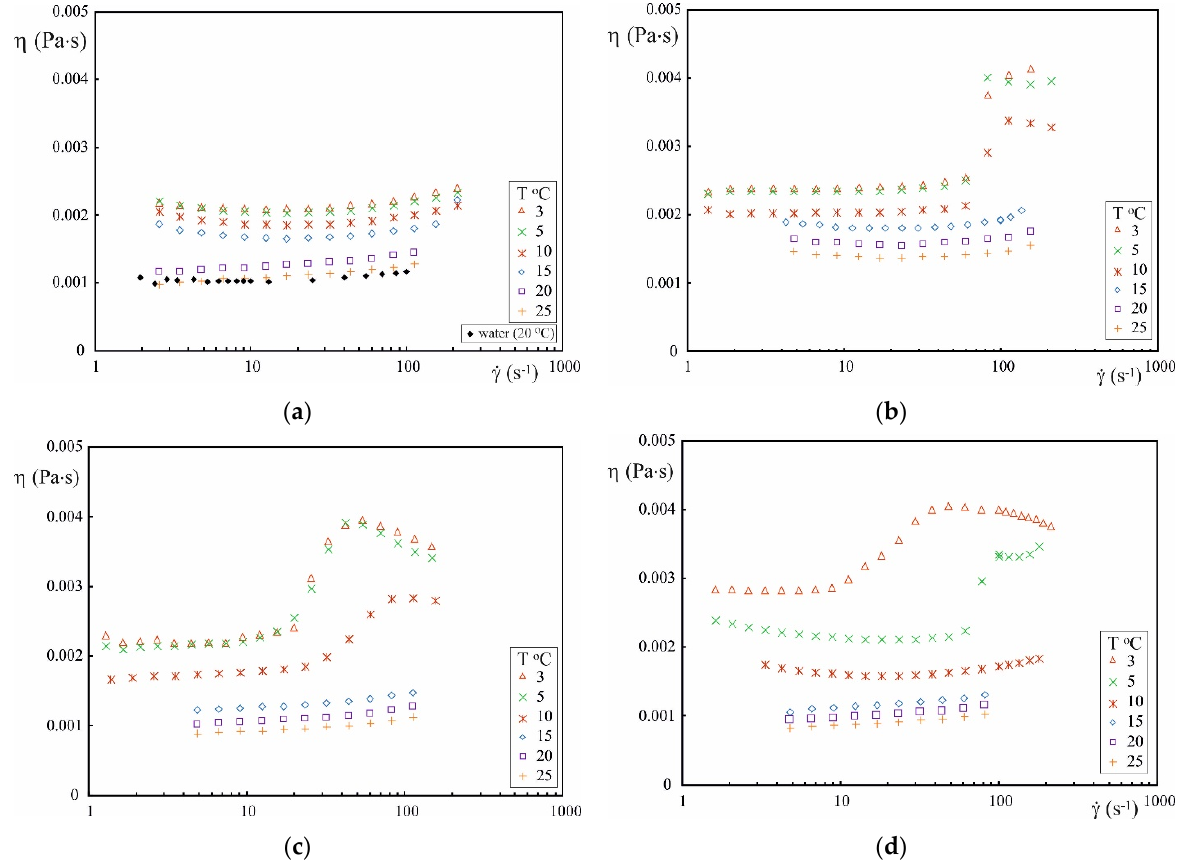
Figure 2. Viscosity curves for aqueous solutions of CAPB/DEA (CAPB = 0.12 wt%) at a concentration of DEA 0.072 wt% ( a ), 0.088 wt% ( b ), 0.1 wt% ( c ) and 0.12 wt% ( d ).